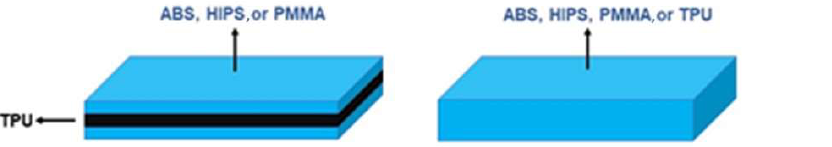
Figure 1. Schematic representation of the printed sandwich structures with ABS, HIPS, or PMMA as skins, and TPU as the core material ( left ) and mono-material specimens ( right ). Table 1. Printing parameters of the printed specimens.